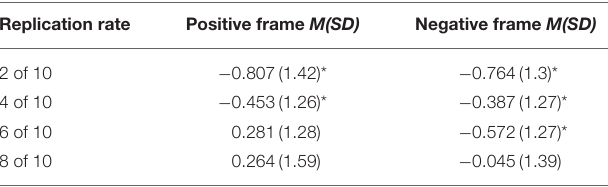
TABLE 4 | Mean and standard deviation of difference scores for Experiment 3.